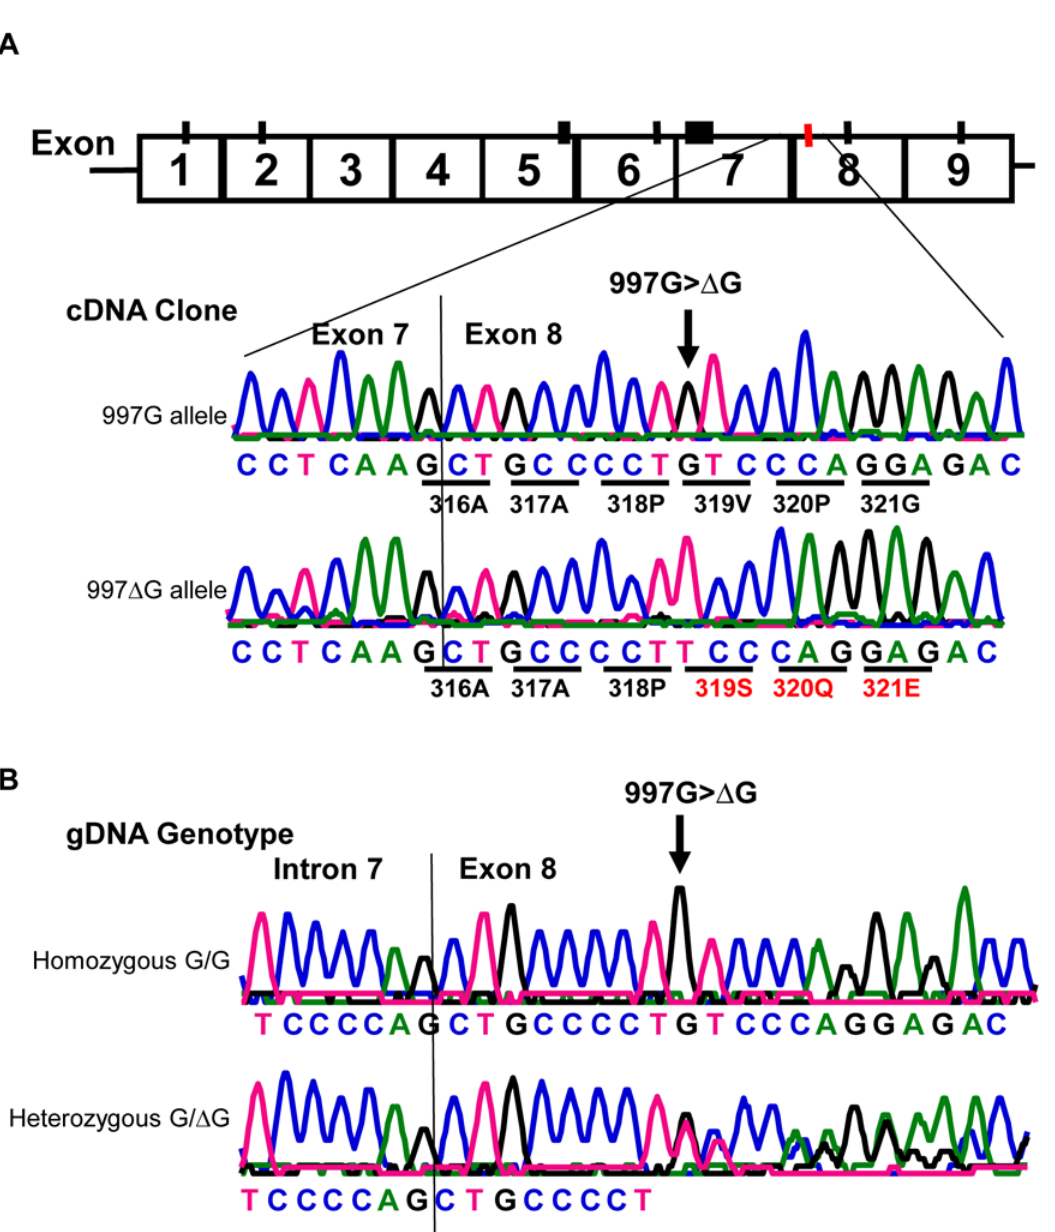
Fig 4. Detection of a rare CD177 nucleotide deletion mutation. A). Sequencing analysis of cDNA clones from two HNA-2 deficient donors who were heterozygous for the SNP 829A > T. The upper tracer is the wild-type (997G allele) CD177 cDNA clone sequence. The wild-type 997G allele is in linkage disequilibrium with SNP 829T (or STP) allele as demonstrated by the sequence of cDNA clones from two HNA-2 deficient donors. The lower tracer is the sequence of CD177 cDNA clone with 997G deletion (designated as 997 Δ G) that is in linkage disequilibrium with SNP 829A allele (or ORF) in CD177 cDNA clones. Those two ORF/STP heterozygous donors manifested as HNA-2 deficient phenotype had the combination of one chromosome carrying 997G deletion (997 Δ G) and the other carrying the 829T (STP) allele. B). Genomic DNA sequence analysis confirmed that the guanidine nucleotide deletion occurs at genomic level. The upper tracer shows the wild-type genomic DNA sequence with the 997G. The lower tracer is the CD177 genomic sequence of a heterozygous donor with one chromosome containing 997G deletion and the other containing the wild-type.